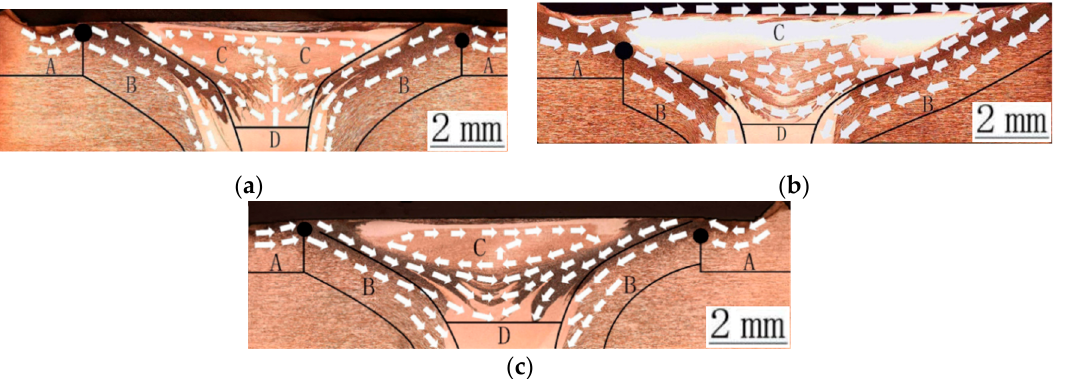
Figure 8. Fluidity of joint metal at different rotational speeds when upsetting speed was 2 mm/s. ( a )